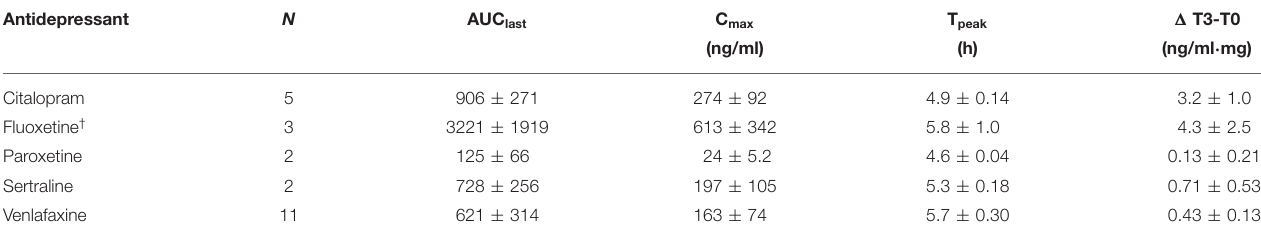
concentration (C max ) between 4.5–6 h (T peak ), followed